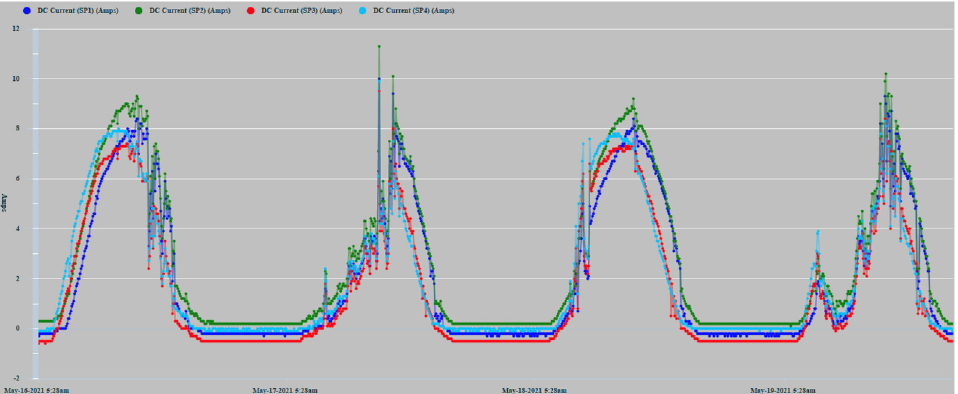
Figure 10. Time series of the current generation of 4 PVMs.